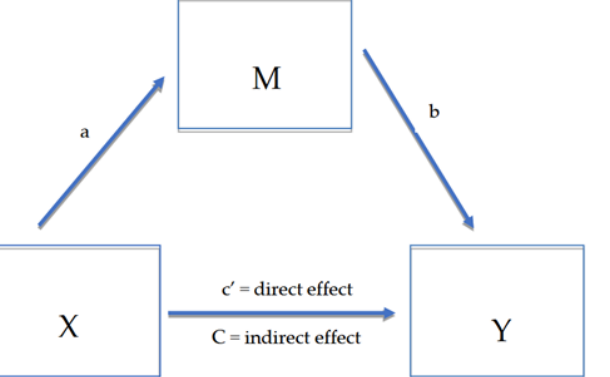
Figure 1. Mediation Model Path. In this model, X denotes one predictor variable, M denotes one mediator, and Y denotes one outcome variable. The parameters a,b,c (cid:48) and C denotes path (regression)